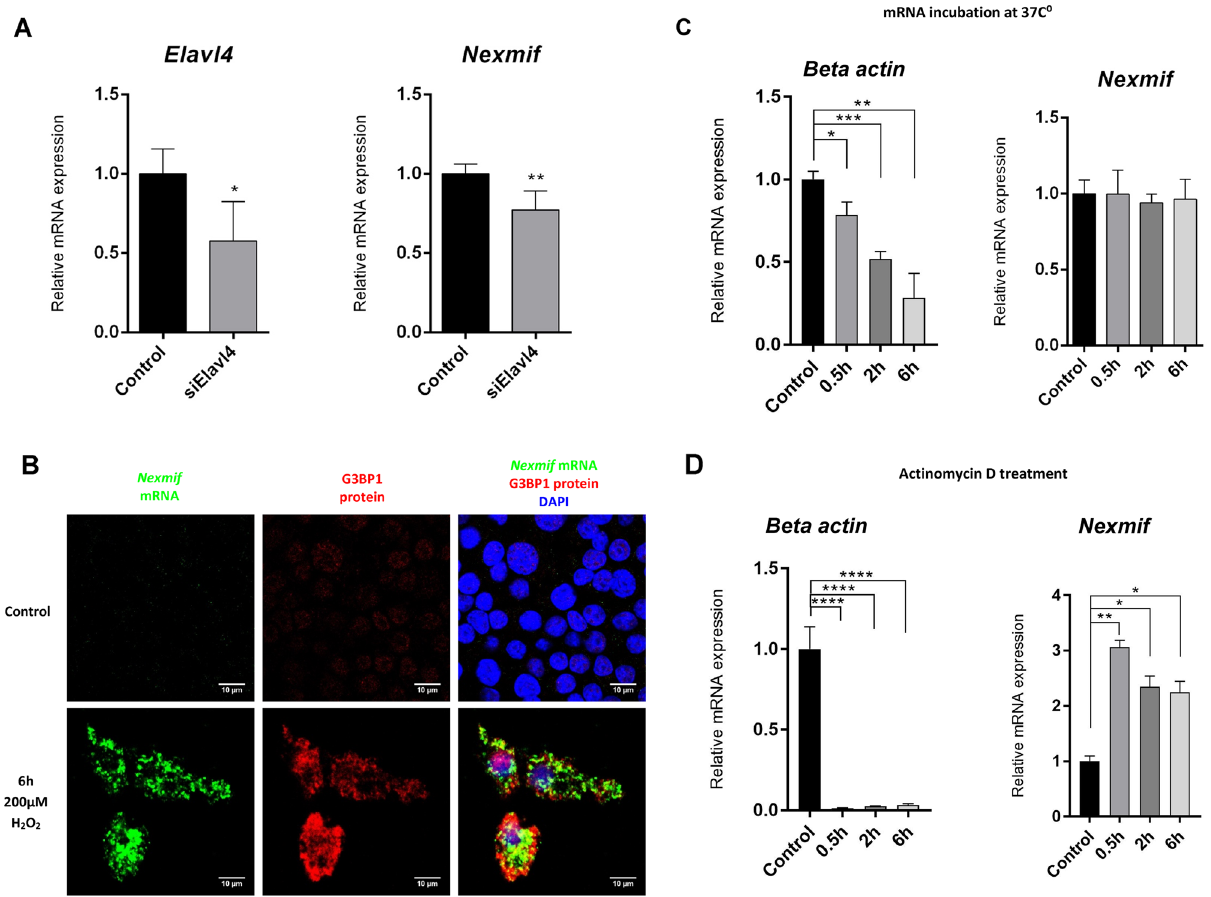
after 6-h H 2 O 2 treatment of INS-1E cells. ( C ) Beta-actin and Nexmif expression in INS-1E cells after incubation at 37 °C for 0 h, 0.5 h, 2 h and 6 h (n = 3). ( D ) Beta-actin and Nexmif expression in INS-1E cells after incubation with 10 µg/mL actinomycin D for 0 h, 0.5 h, 2 h and 6 h (n = 3). Error bars, standard deviation; n, sample